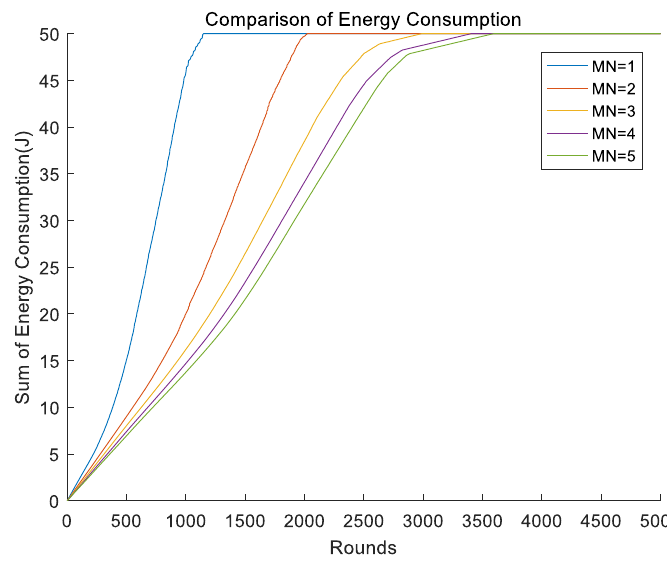
Figure 16. Energy consumption of different numbers of mobile sinks.